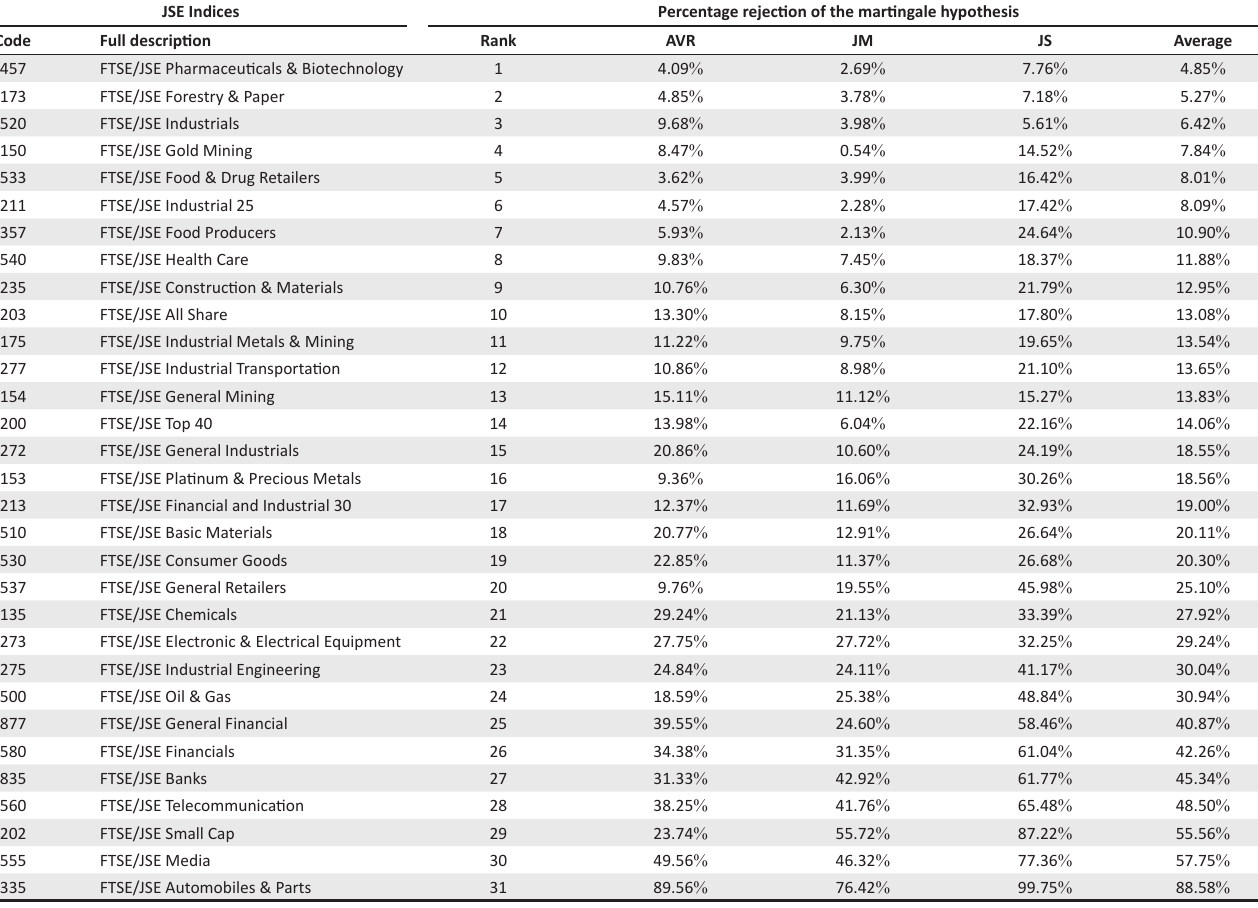
TABLE 2: Efficiency